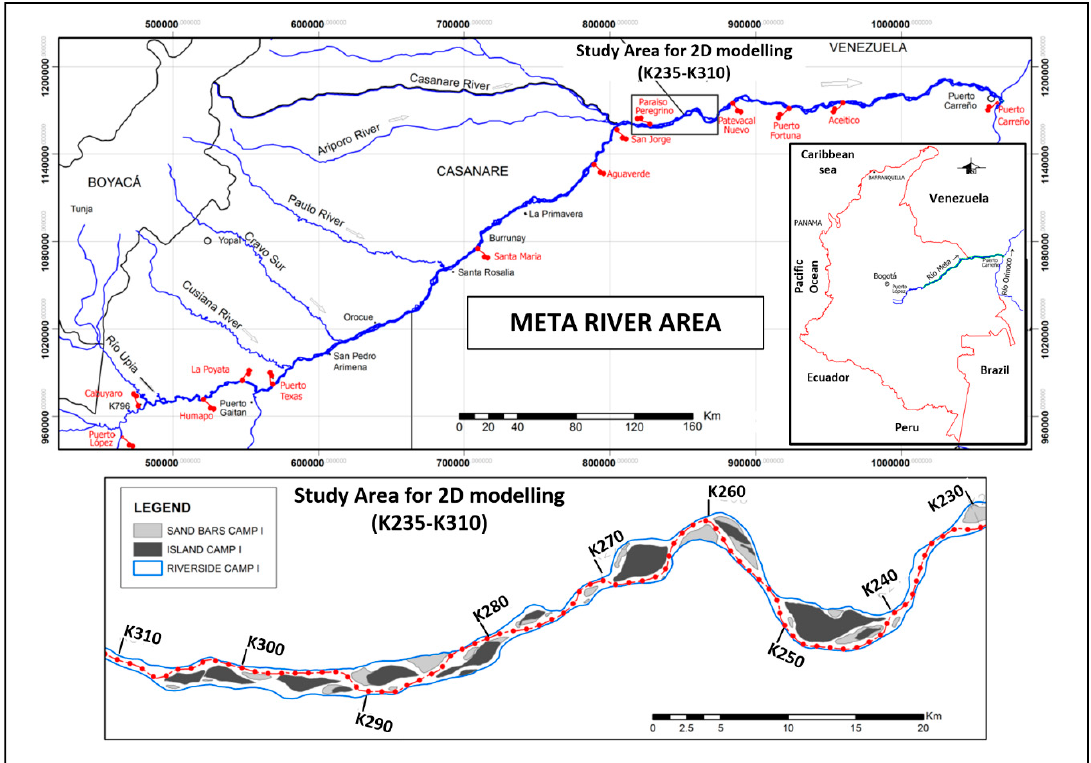
Figure 2 . Representative section of the river, between K235–K310. Figure 2. Representative section of the river, between